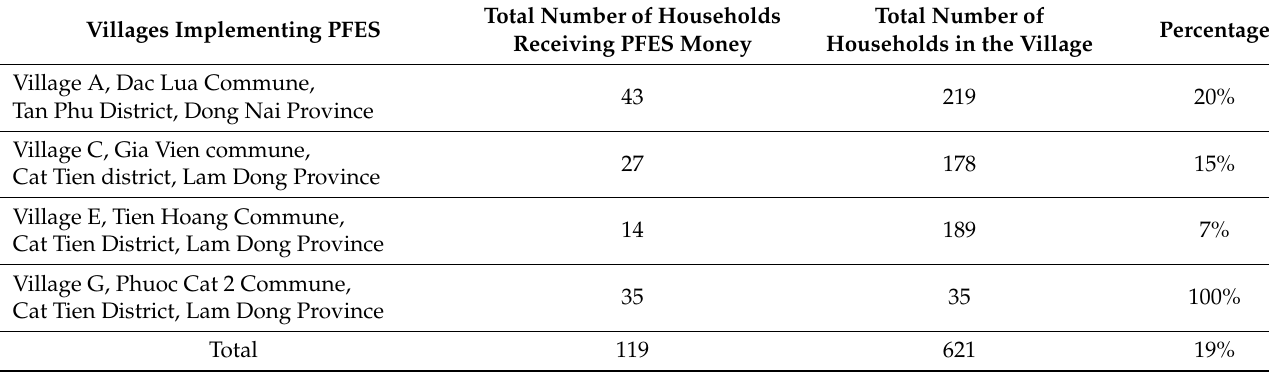
Table 8. Households receiving PFES